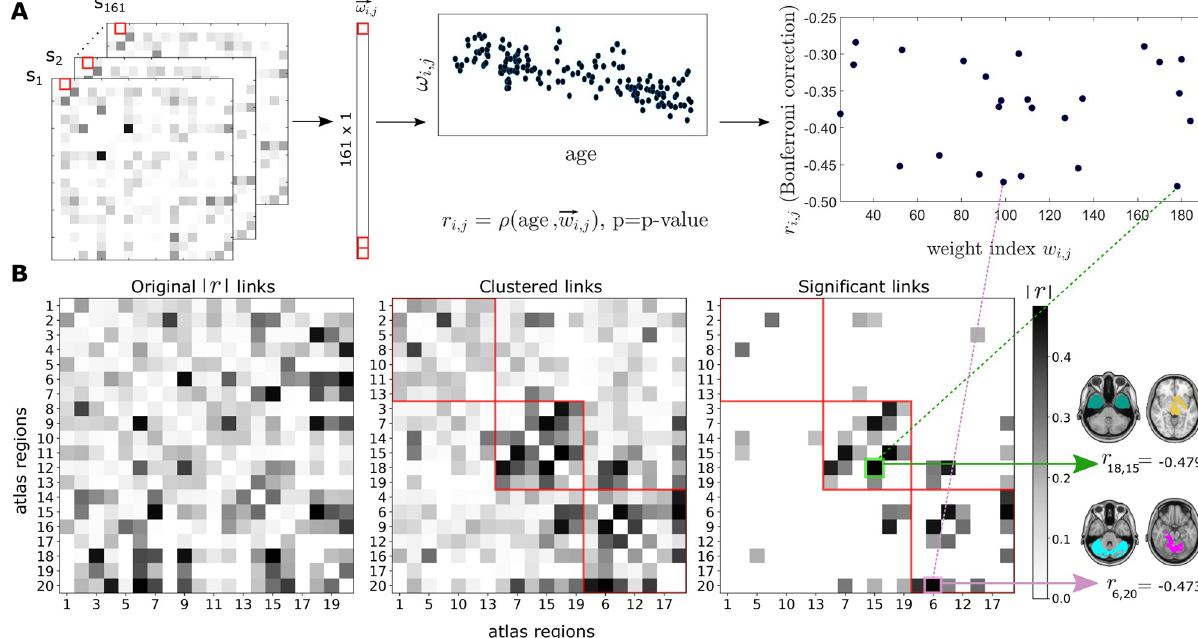
Fig 4. Heterogeneity of the connectome degeneration. A : The non-parametric Spearman’s rank-correlation r between age and individual weights w of the SC matrix was calculated across all different participants (N = 161). The final number of weights that survived to multiple comparisons is represented in the right panel, with values ranging from -0.25 to -0.50. B : We built a new connectivity matrix using as links the absolute values of r obtained for each weight (left panel). Next, the Leuven community detection method was applied before correcting for multiple comparison and three main communities (center) were found. The links that belong to each community and that survived Bonferroni correction are also shown (right). As an illustration, we show one arbitrary link within each of these communities (colored in green and pink). Here, | r | denotes the absolute values of all elements of matrix